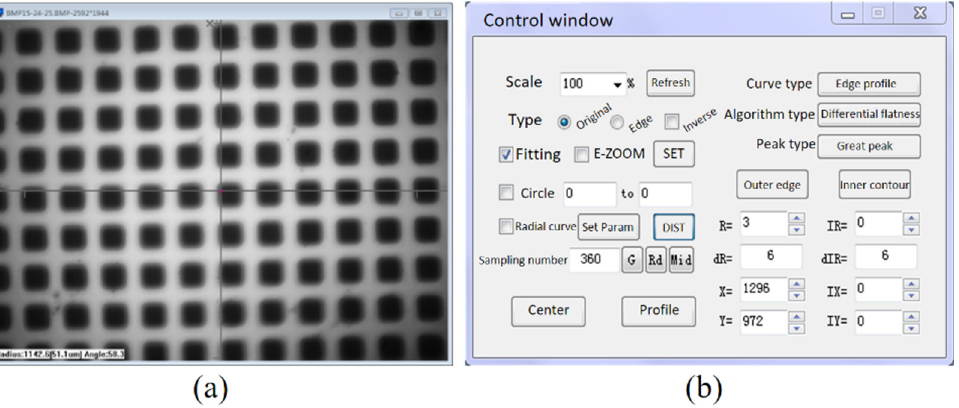
Figure 6. ( a ) The experimental image obtained by the industrial camera. ( b ) The operating interface of the developed image processing software.